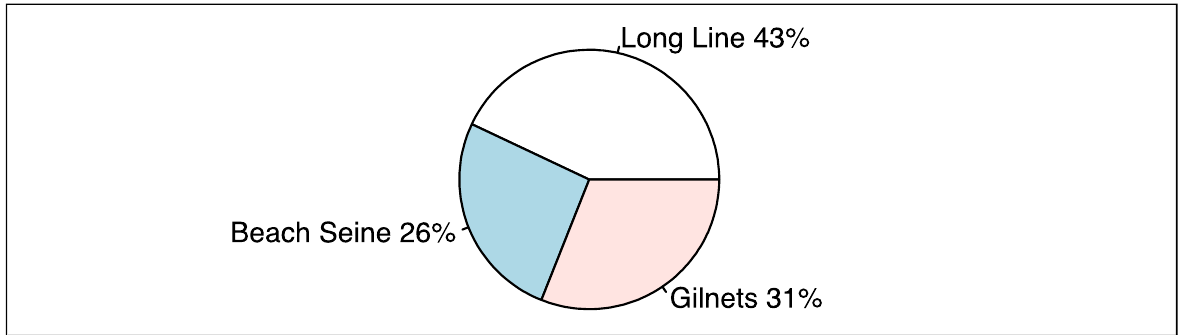
Figure 2: Contribution to total landings of each gear used in the Nile perch fishery at three landing sites in Magu district, Lake Victoria